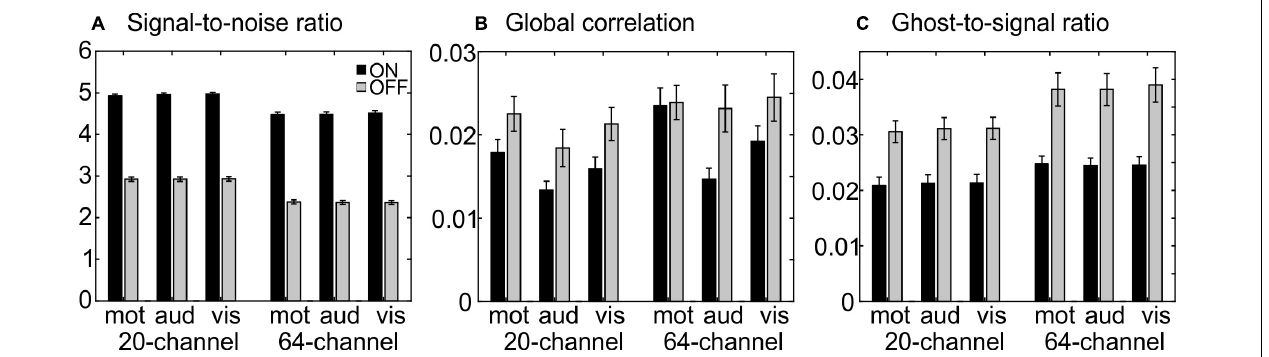
FIGURE 2 | MRIQC results for the functional data: (A) results for the signal-to-noise ratio; higher values are better. (B) Results for global correlation; smaller values are better. (C) Results for the ghost-to-signal ratio; lower values are better. Each figure represents the different tasks (motor, auditory, and visual) separated for each head coil (blocks on the left side for the 20-channel head coil and on the right side for the 64-channel head coil) as well as the prescan normalize ON (black) and OFF (gray)